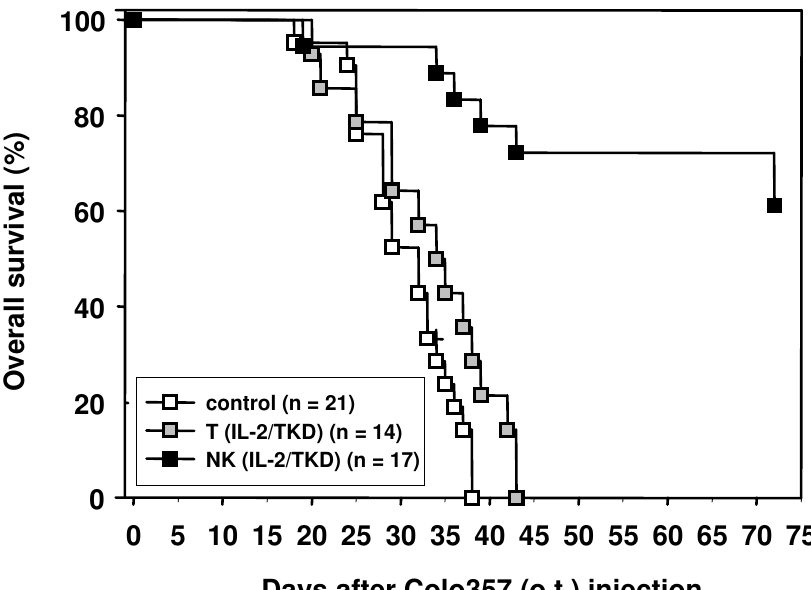
Fig. 4 Overall survival of tumor-bearing control mice and after treatment with TKD/IL- 2-stimulated T and NK cells, respectively. 15 days after o.t. injection of Colo357 pancreas carcinoma cells, SCID/beige mice received a single i.v. injection of either medium (con- trol), IL-2/TKD-activated CD3+/CD94- T or CD3-/CD94+ NK cells into the tail vein. The increased survival of mice injected with IL-2/TKD-activated NK cells was significant (p < 0.01) compared to control